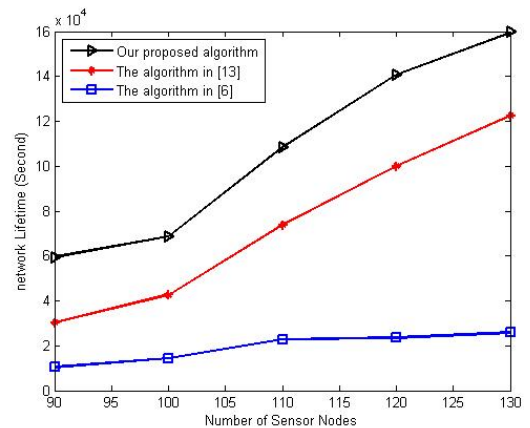
Figure 9. Influence of increasing number of sensor nodes on network lifetime. Table 6. Initial deployment strategies.